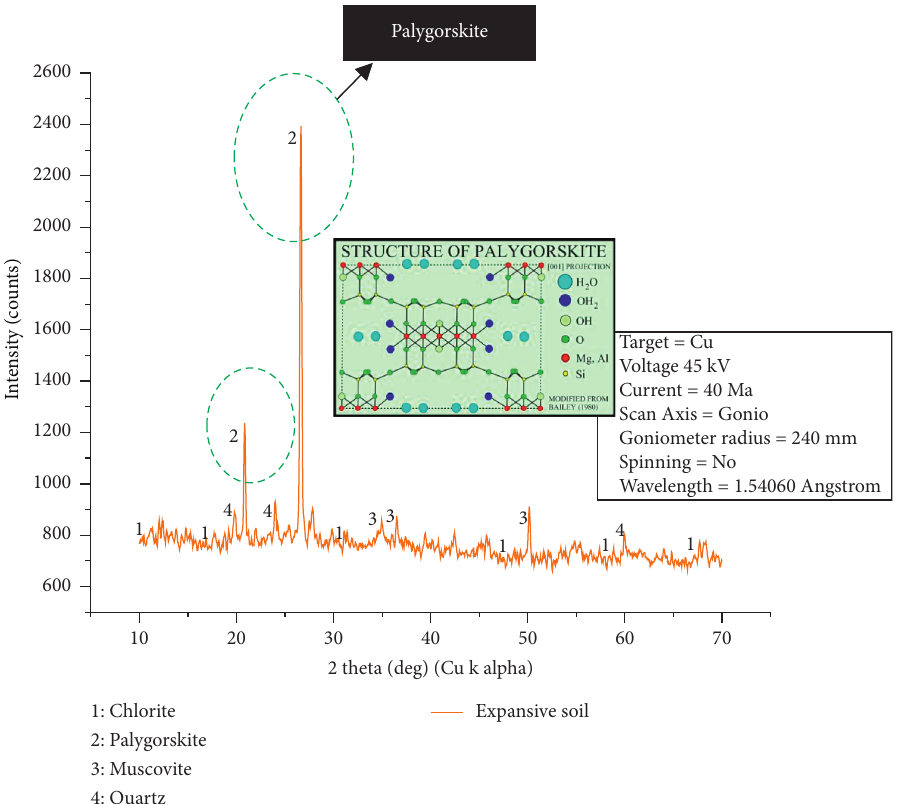
Figure 5: Diffracting peak patterns of X-rays from planes of minerals in plain expansive